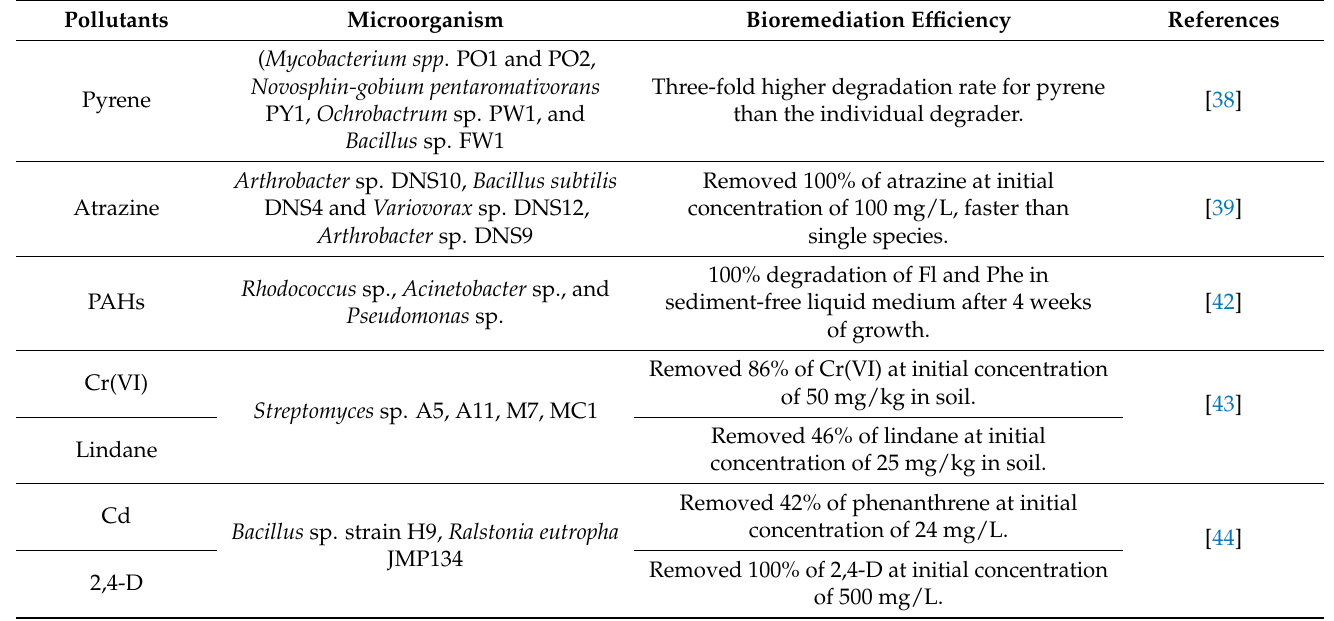
Table 1. Cases of engineering microbial consortia towards